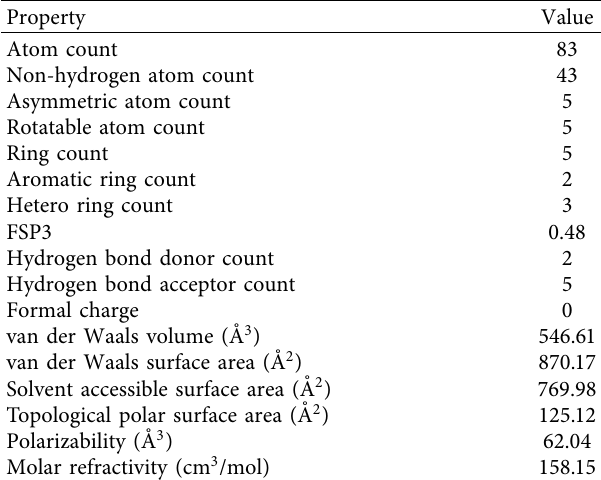
Table 3: HOMO, LUMO, and SOMO energies,